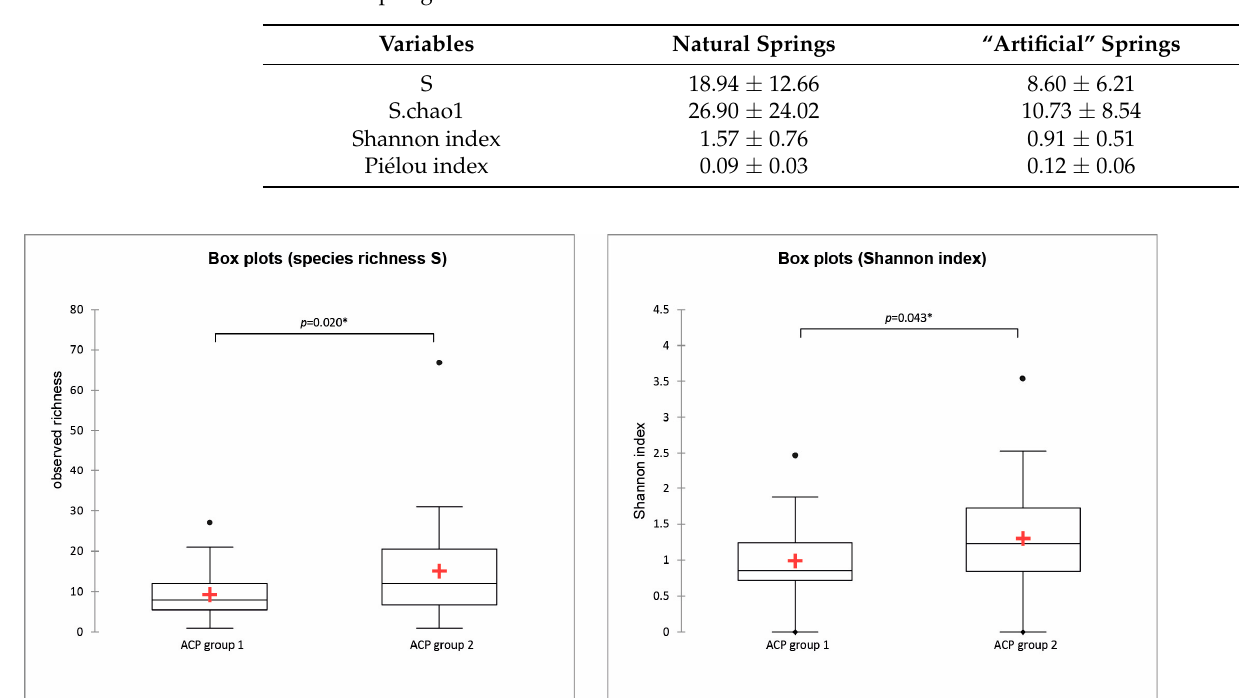
Figure 5. Box plots of the significant parameters (using Kruskal–Wallis tests) performed on the studied springs. The red crosses represent the mean of data and the black bullets, the outlier points. * represent the statistically significant p -value.